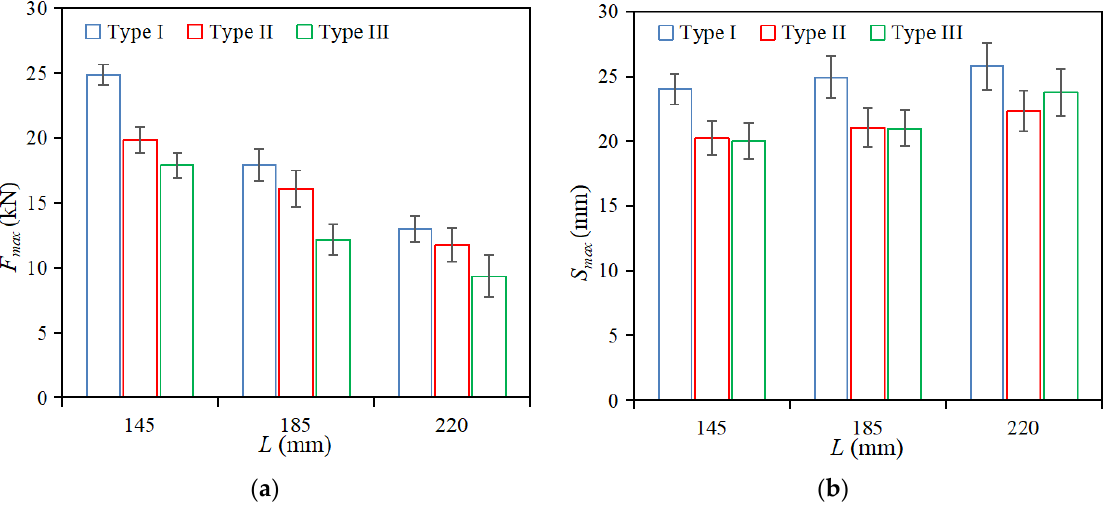
Figure 2. The average and standard deviation of F max ( a ) and S max ( b ) for the specimens with different cross-sections and lengths, calculated from the experimental data.